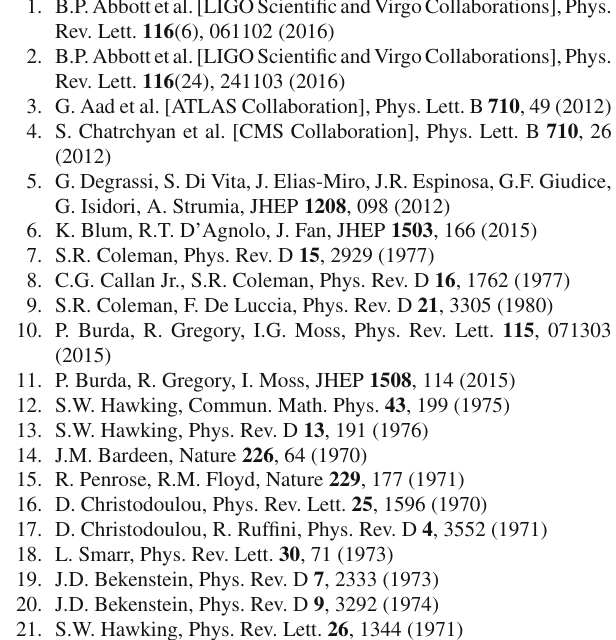
(b) The bounds for g 1 = g 2 cases un- der ρ = 1, M 1 = 1, a 1 = 0 . 2, and M 2 = 1.